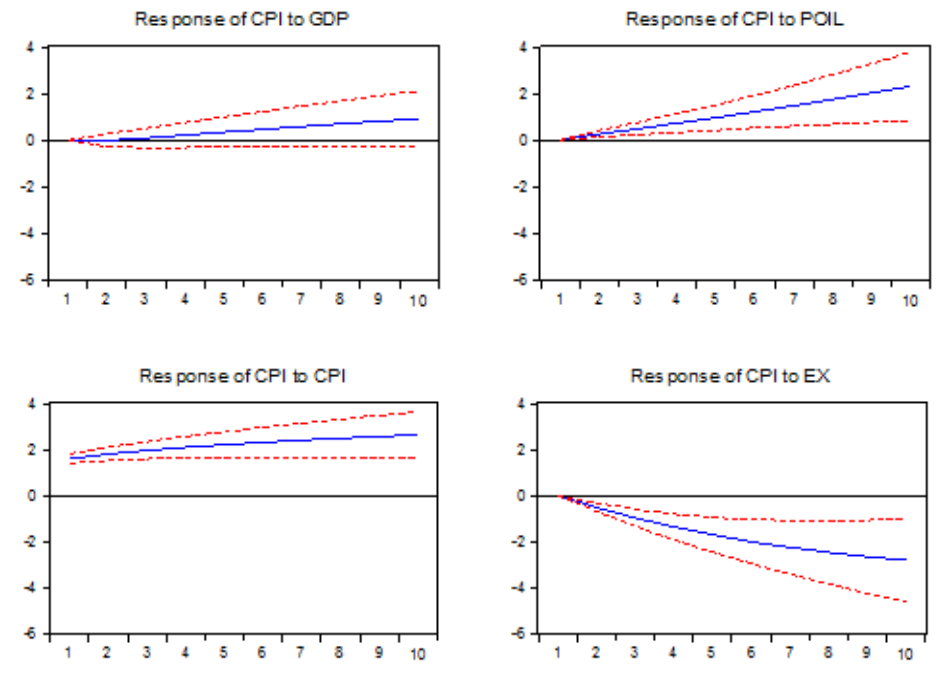
Figure 1. Impulse response functions when shock is applied to inflation